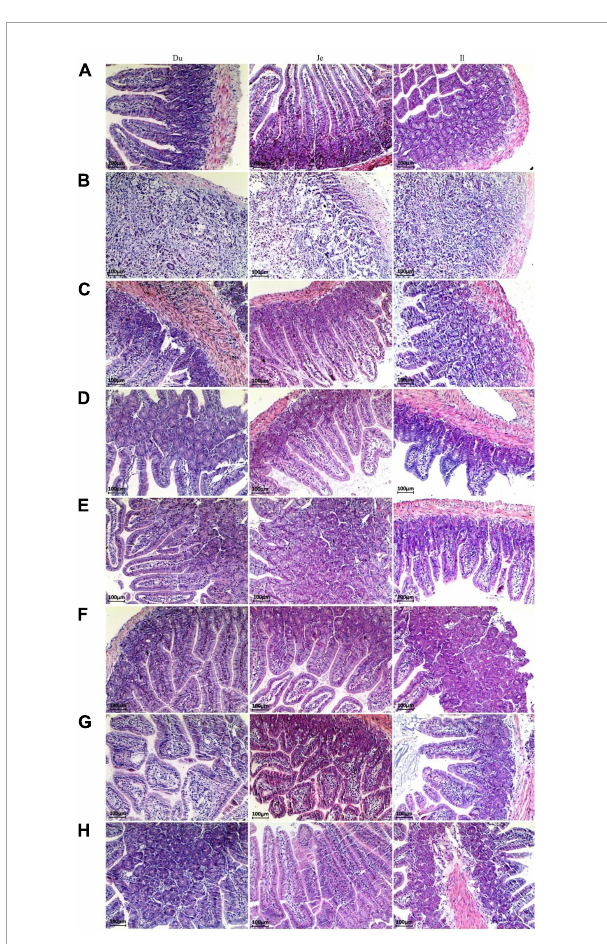
FIGURE2 Paraffin sections of the small intestine of mice after different treatments. Morphological images of small intestine are shown at 40 × magnification. Panels (A–H) represent NC, CPM, CPC, EDC, EF, BS, LS, MC group. Du: Duodenum; Je: Jejunum; Il: Ileum.